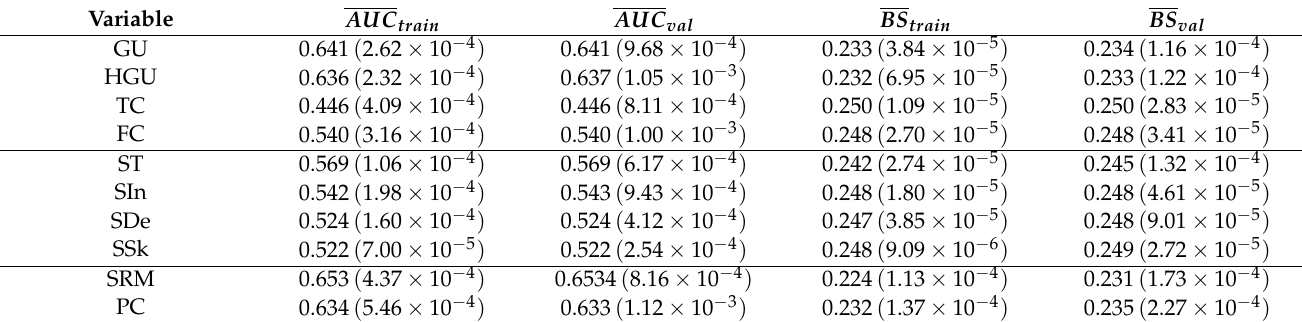
Table 3. Average values of AUC and Brier score on training and validating datasets for associated variables. Standard deviation is given in parentheses. Variables selected for the logistic regression model are highlighted in green.